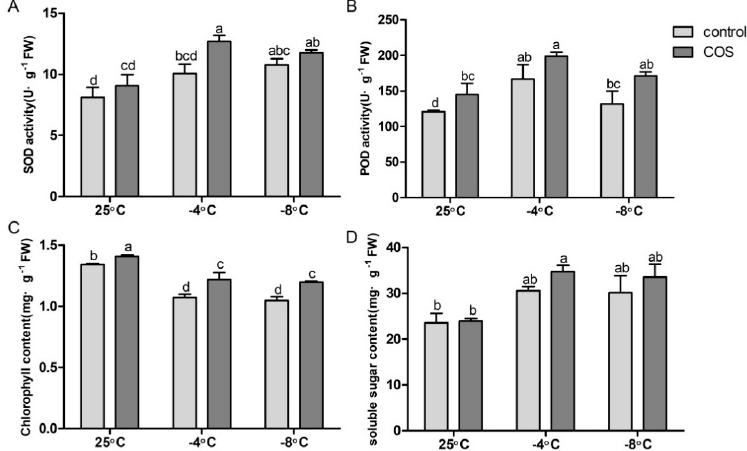
Figure 1. Effect of chitosan oligosaccharide (COS) on physiological parameters of tea leaves. ( A ) Superoxide dismutase (SOD) activity; ( B ) peroxidase (POD); ( C ) chlorophyll content; ( D ) soluble sugar content. The data represent the means ± SD of three replicates samples. Different letters indicate significant differences at p < 0.05.